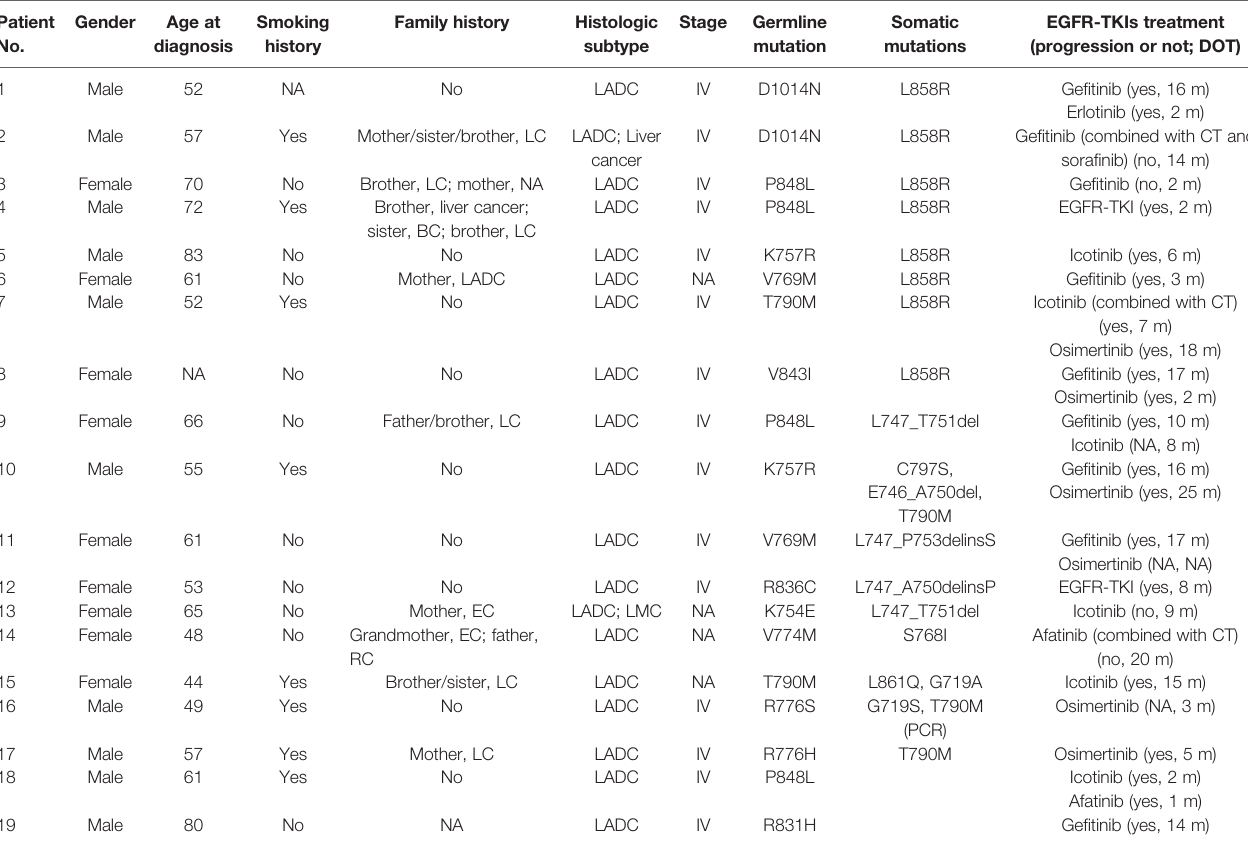
TABLE 2 | The clinical and genetic features and patients ’ response to EGFR-TKIs in patients with germline EGFR mutations. Patient